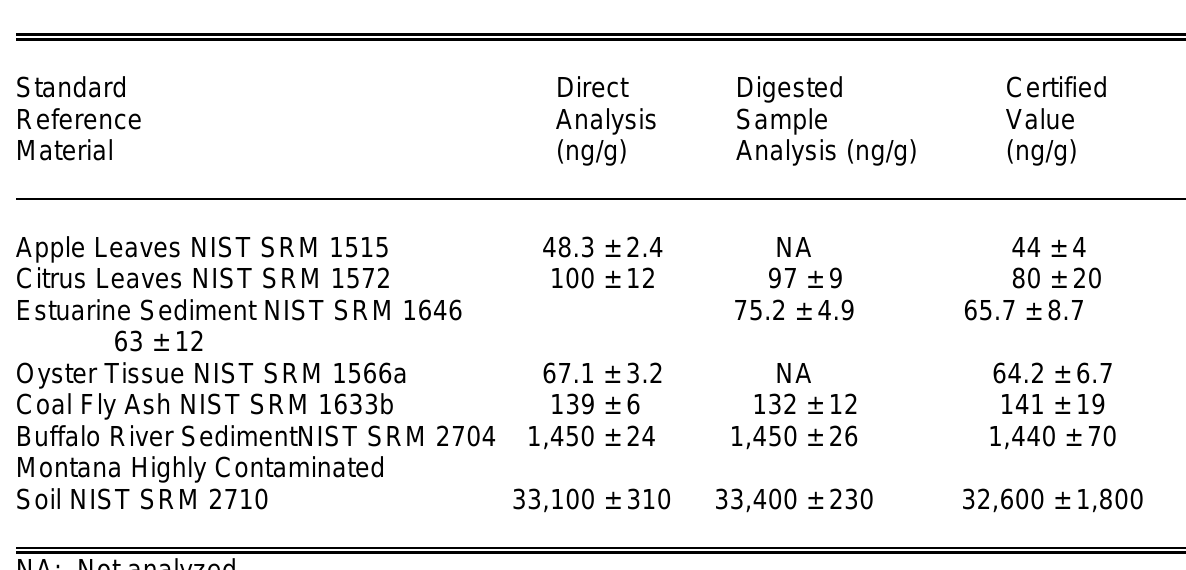
EXAMPLE LABORATORY ANALYSIS RESULTS (MEAN ± 95% CONFIDENCE INTERVAL) OF DIRECT AND DIGESTED (METHOD 3052) ANALYSES OF VARIOUS NIST SRMs USING THE DMA 80 (MILESTONE, INC.)